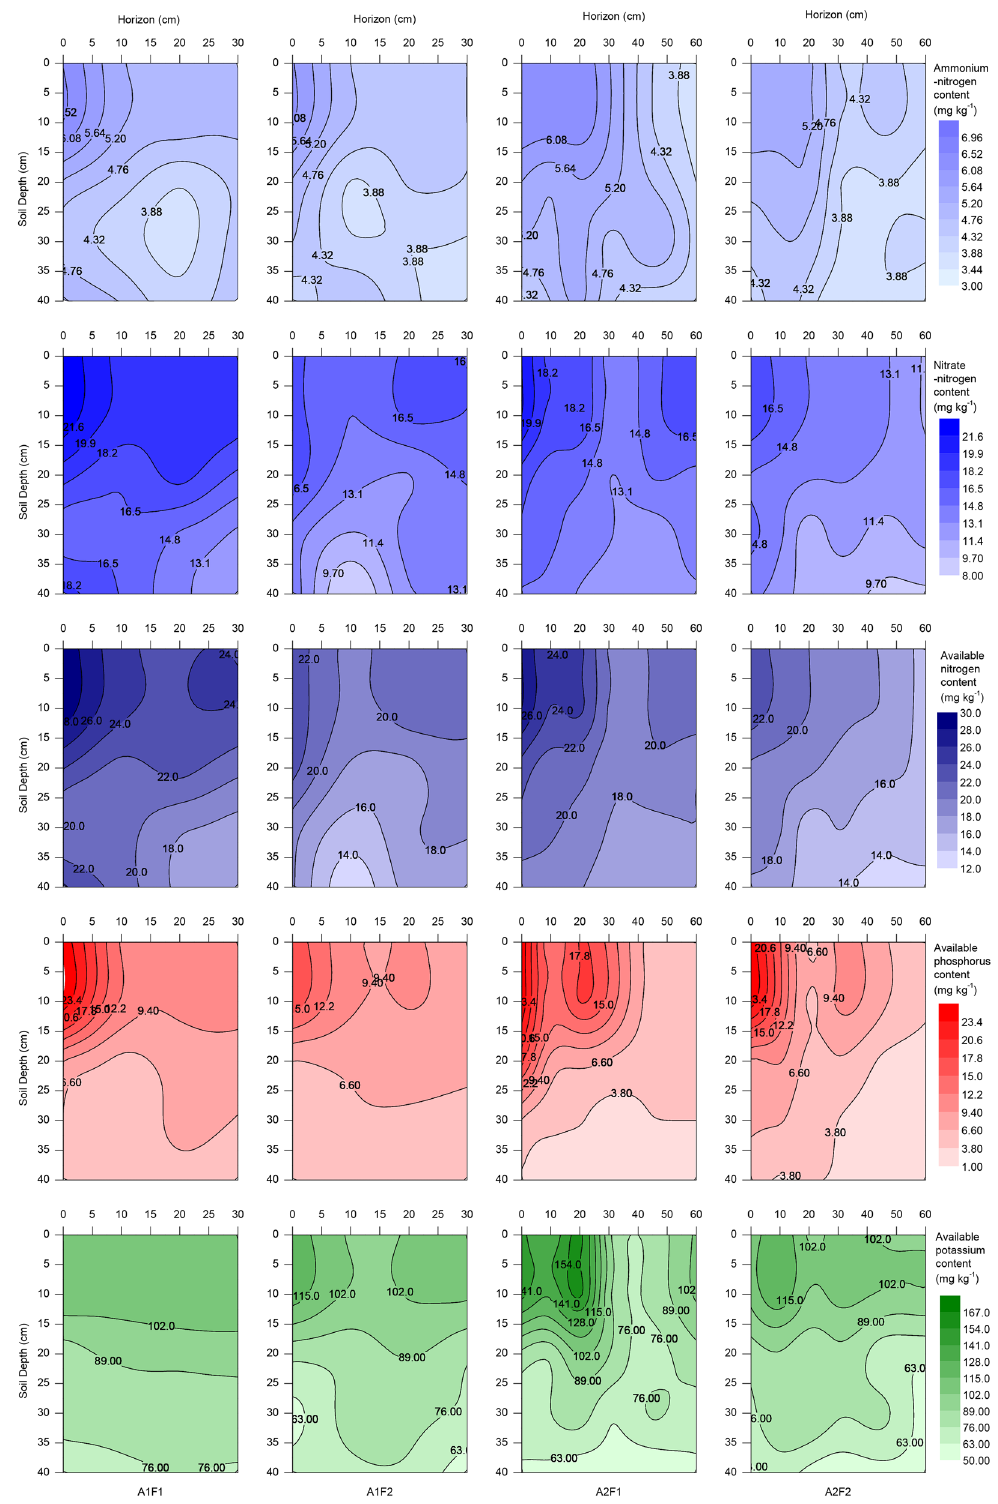
Figure 7. The distribution of soil nutrients content (ammonium-nitrogen, nitrate-nitrogen, available nitrogen, available phosphorus, and available potassium) at harvest in the 2017 maize season. See Fig. 2 and Table 2 for treatment description. Graphs were created using Origin software version 2021 (Origin Lab Ltd., Guangzhou, China). Origin is used herein under license. Copyright OriginLab Corporation. All rights reserved. For more information about Origin software, please visit www. origi nlab.